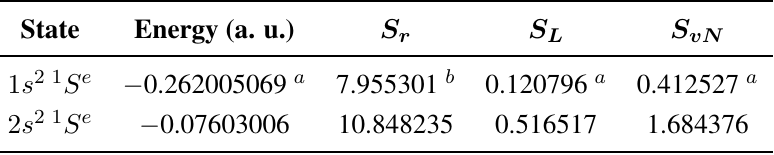
Table 2. Entropies in the ground and doubly excited states of Ps −